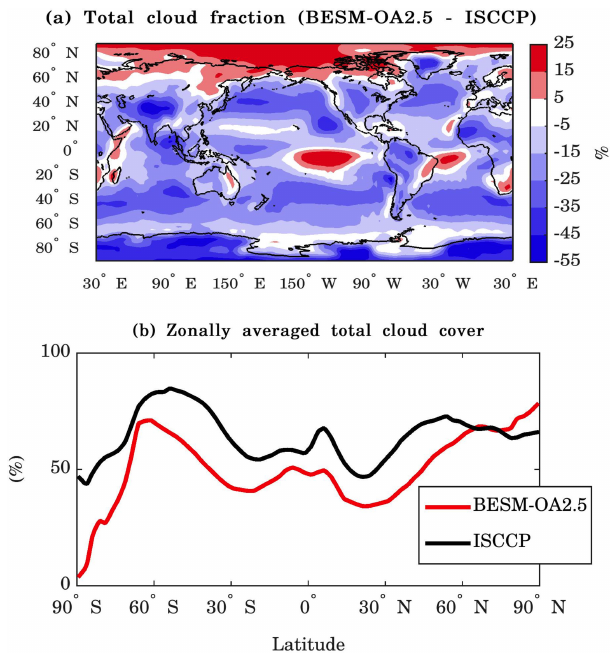
Figure 7. (a) Spatial map of annual mean total cloud fraction bias of BESM-OA2.5 relative to ISCCP. (b) Zonally averaged total cloud cover for the BESM-OA2.5 and ISCCP datasets. The periods used were 1971–2000 and 1984–2009 for BESM-OA2.5 and ISCCP, re- spectively. Units are in